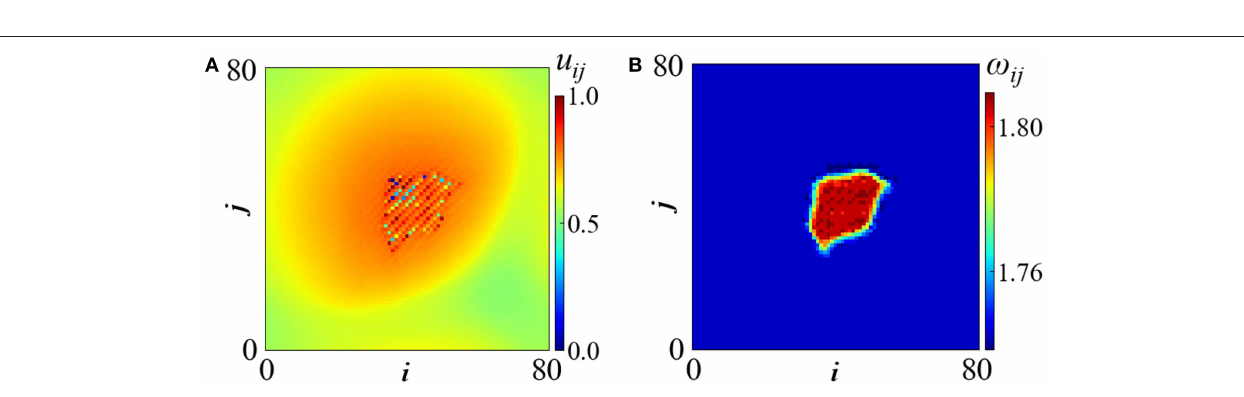
fronts are similar to the size of the initiation connectivity